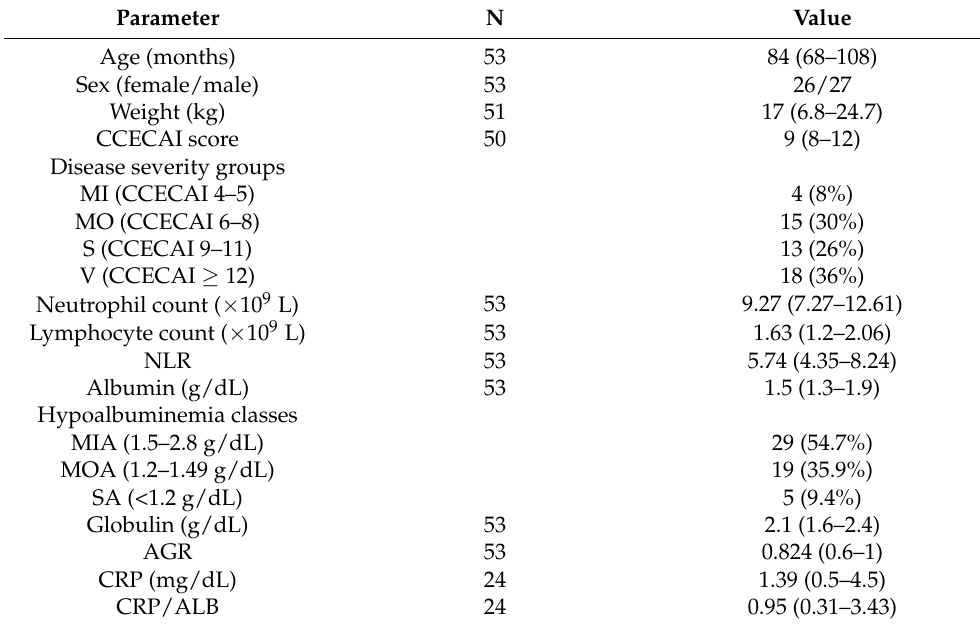
Table 2. Selected clinicopathological characteristics of dogs with IRE-PLE before endoscopic procedure (T0).